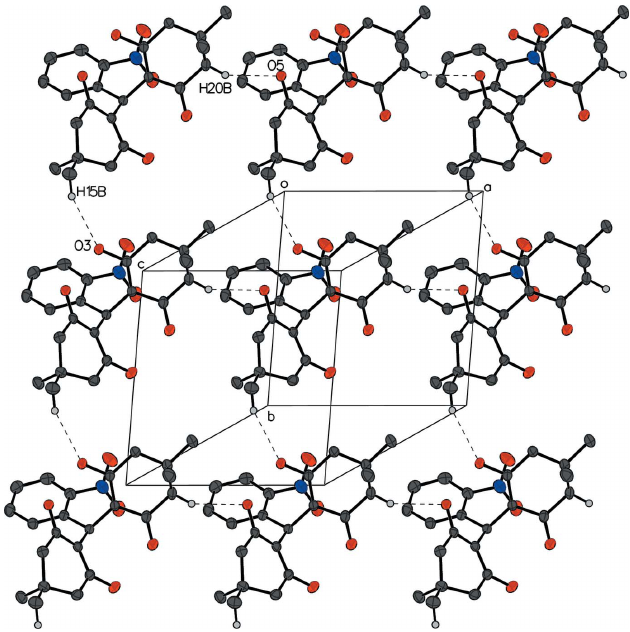
Figure 5 The packing of compound I showing the two-dimensional network parallel to the (001) plane. For clarity, H atoms not participating in hydrogen bonds are omitted, and participating atoms are labeled once.